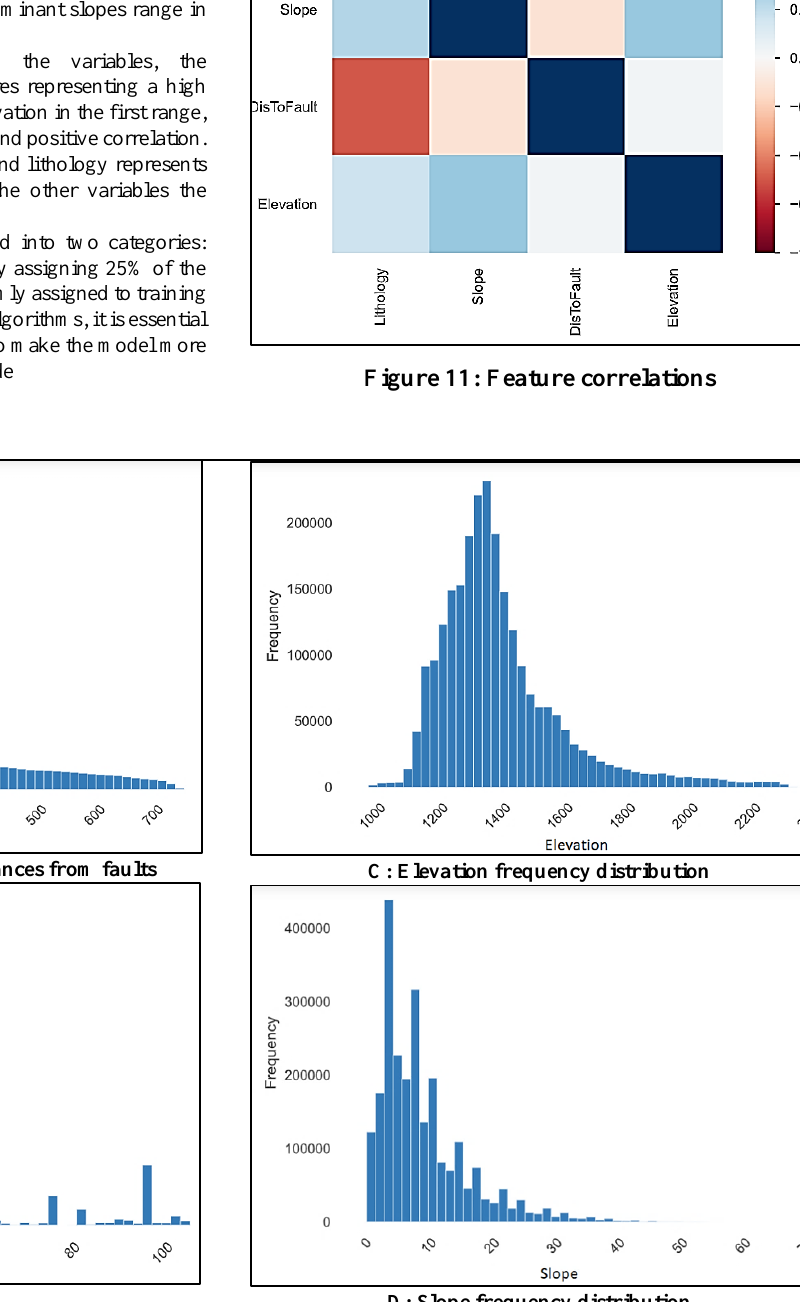
Figure 12: (A, B, C, D) Features frequency